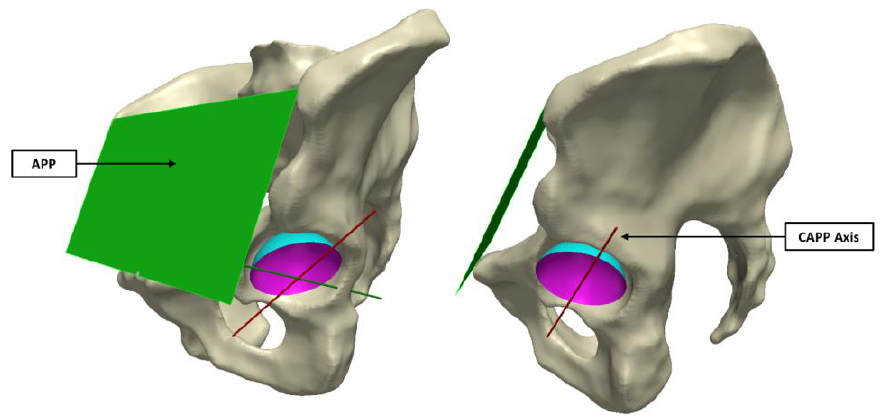
Figure 3. The CAPP axis was defined using a plane parallel to the APP ( left image), which intersected the centre of the sphere formed by the acetabular surface ( right image).